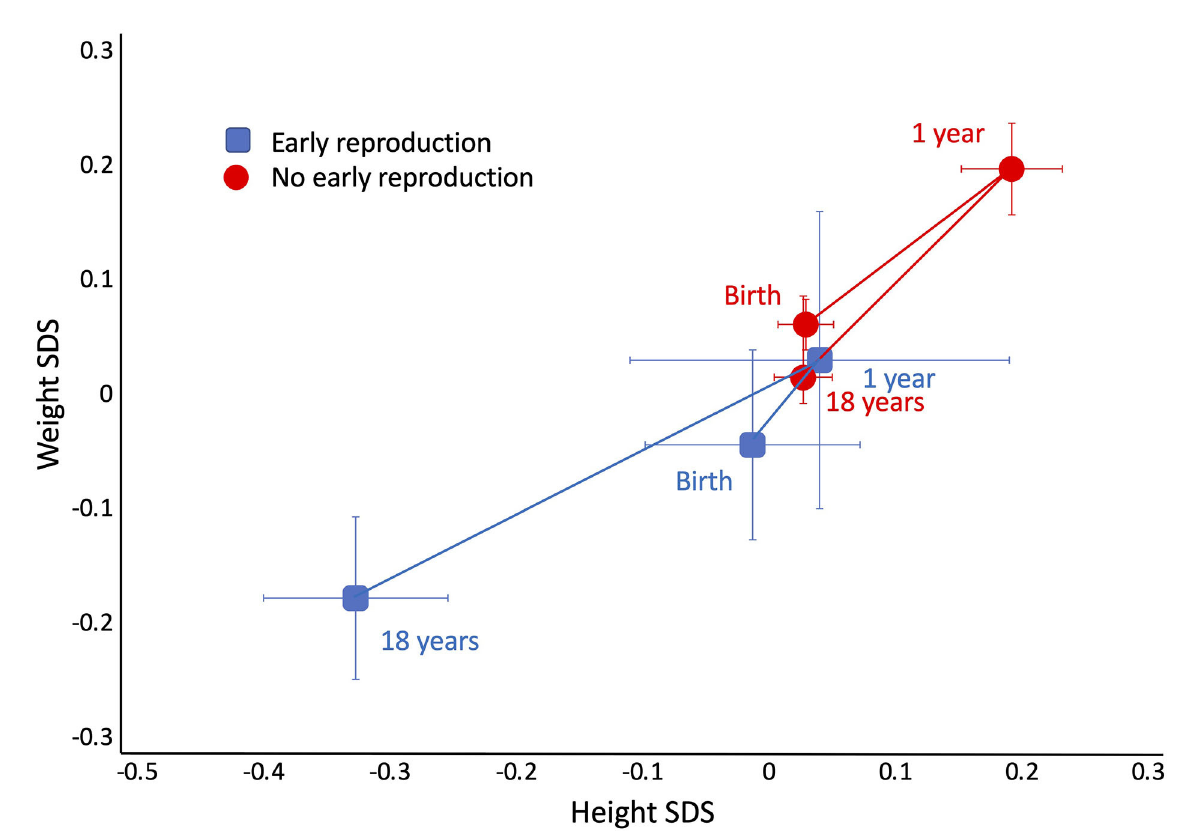
FIGURE4 Trajectories of growth in length/height z -score and weight z -score in the sons, stratified by whether they had reproduced by 18 years (blue points) or not (red points). Early reproducing sons were similar to their non-reproducing sons at birth, and both groups showed a small degree of catch up between birth and 1 year. From this time point, early reproducing sons showed poorer growth, resulting in lower weight and height at 18